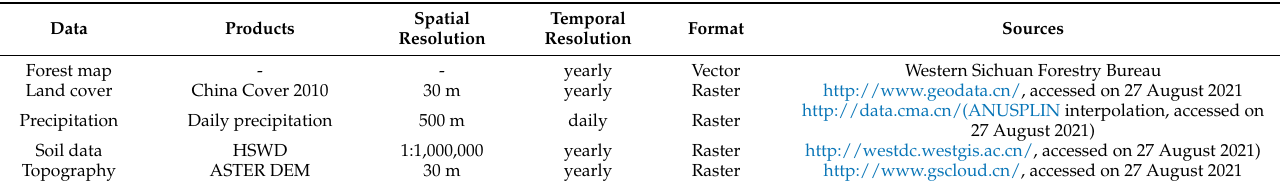
Table 1. Data introduction.